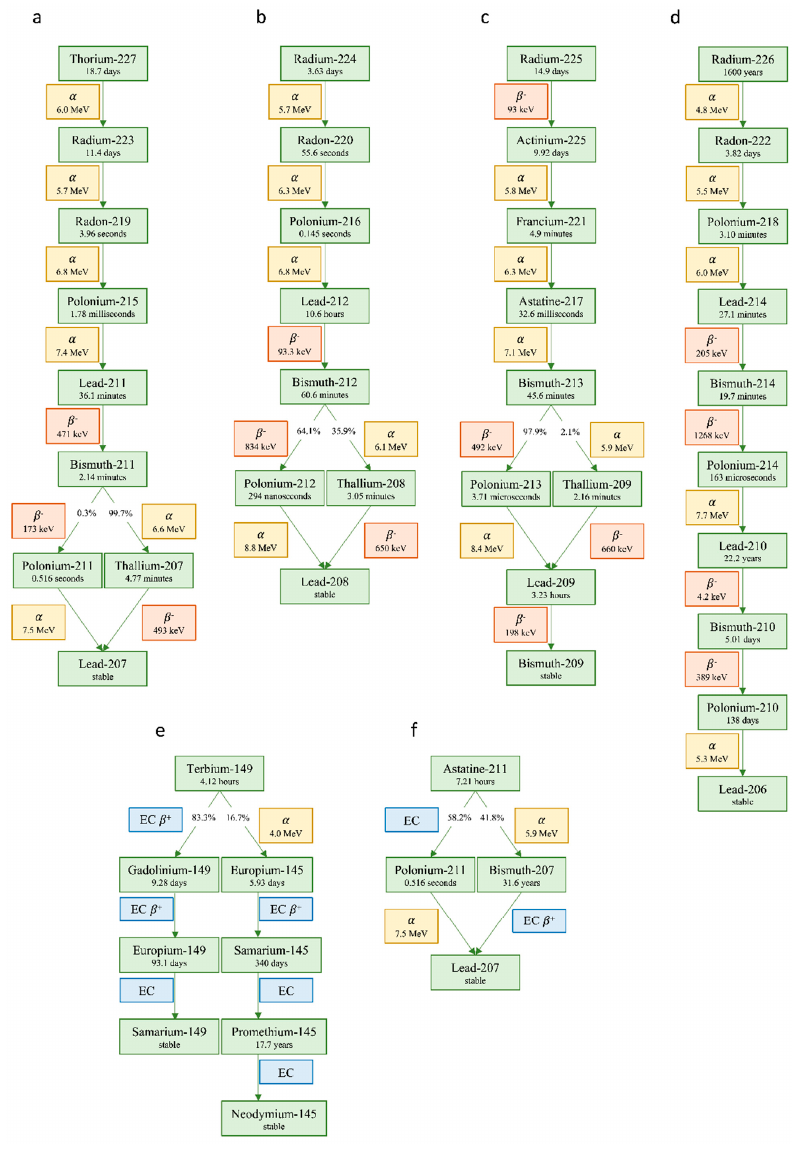
Figure 6. Six decay schemes ( a – f ), including most alpha-emitters relevant for radionuclide therapy. All branching ratios larger than 0.1% are included. The beta- and alpha-particle energies given are for the highest intensity emission. Data from Ref. [96].